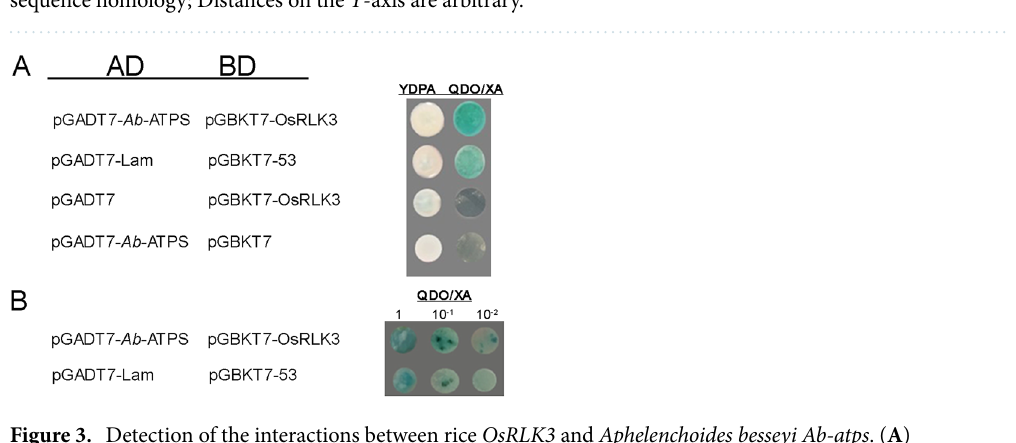
Figure 3. Detection of the interactions between rice OsRLK3 and Aphelenchoides besseyi Ab-atps . ( A ) Interaction of OsRLK3 and Ab-atps. Yeast cells transformed with pGBKT7-OsRLK3 (BD) and pGADT7- Ab- ATPS (AD) were grown on YDPA media plates and then printed onto QDO/XA (SD/-Leu/-Trp/-Ade/-His/X-α- gal/AbA) plates, and the colony turned blue; yeast cells transformed with pGADT7-Lam and pGBKT7-53 were used as positive controls; yeast cells were transformed with pGADT7 and pGBKT7-53 were used as negative controls. ( B ) Serial dilutions (1, 10 –1 , 10 –2 ) of the yeast cells with pGBKT7-OsRLK3 (BD) and pGADT7- Ab - ATPS (AD) were cultured on QDO/XA plates for 1 day to detect their interaction